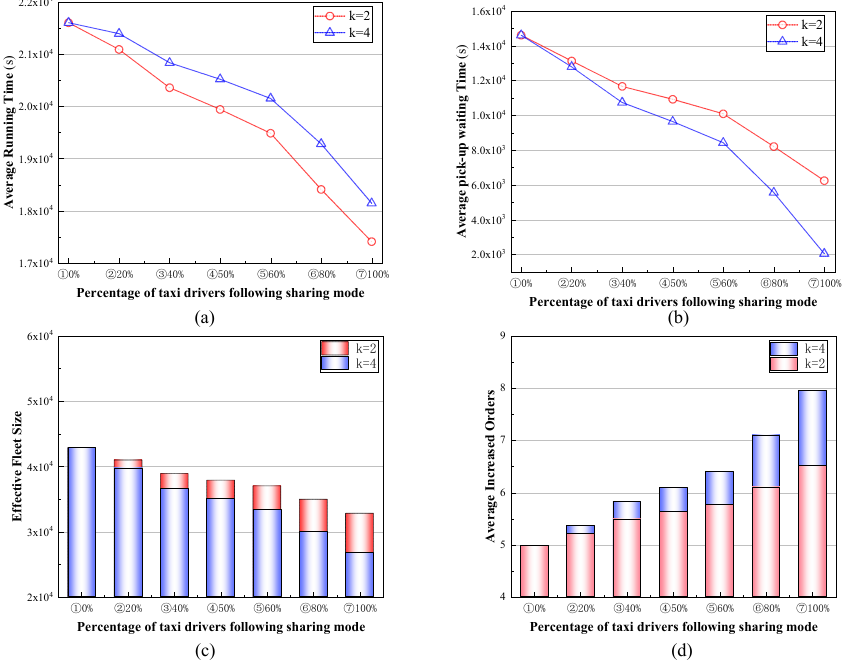
Figure 11. Impact of the different driver’s percentage participating in sharing mode. ( a ) is the average running time, and ( b ) is the average pick-up waiting time. ( c , d ) are the effective fleet size and average increased orders based on different percentage of taxi driver’s following sharing mode.